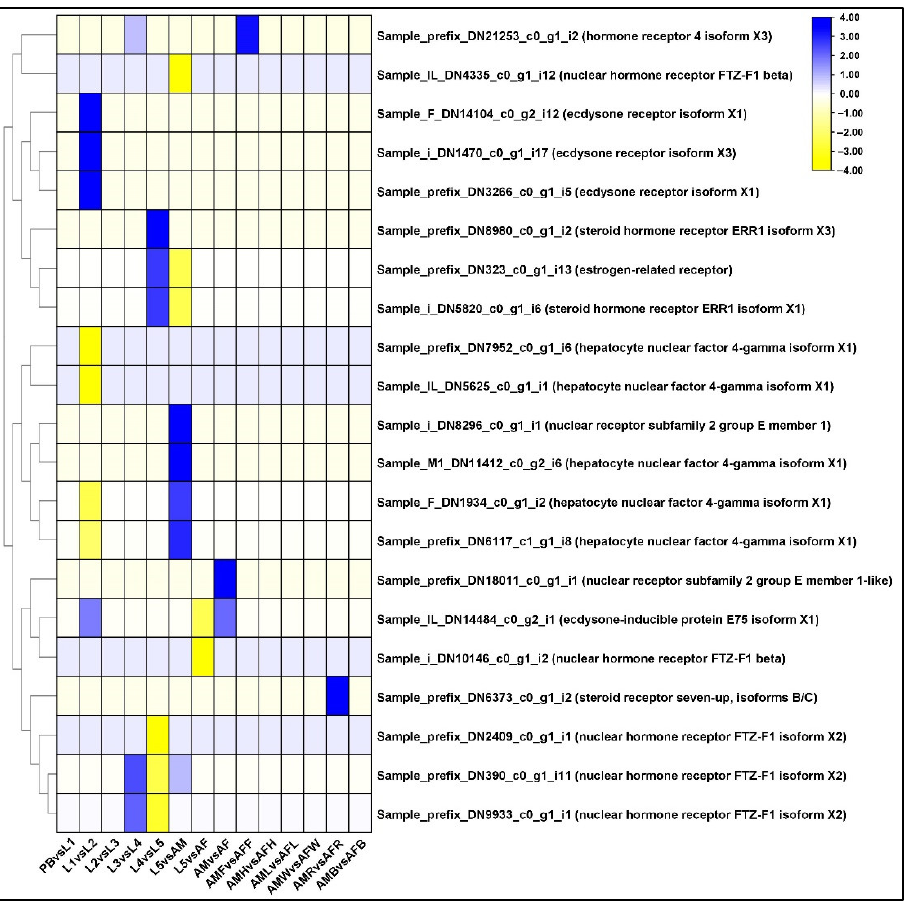
Figure 6. Identification of genes assigned to the Ecdysone biosynthetic (EH) pathway in the P. bremeri transcriptome. KAAS was used to identify genes annotated by BLAST against the specific insect database and assigned to a KEGG pathway. Heat map showing the log2-fold change of the FPKM values of the DEGs.